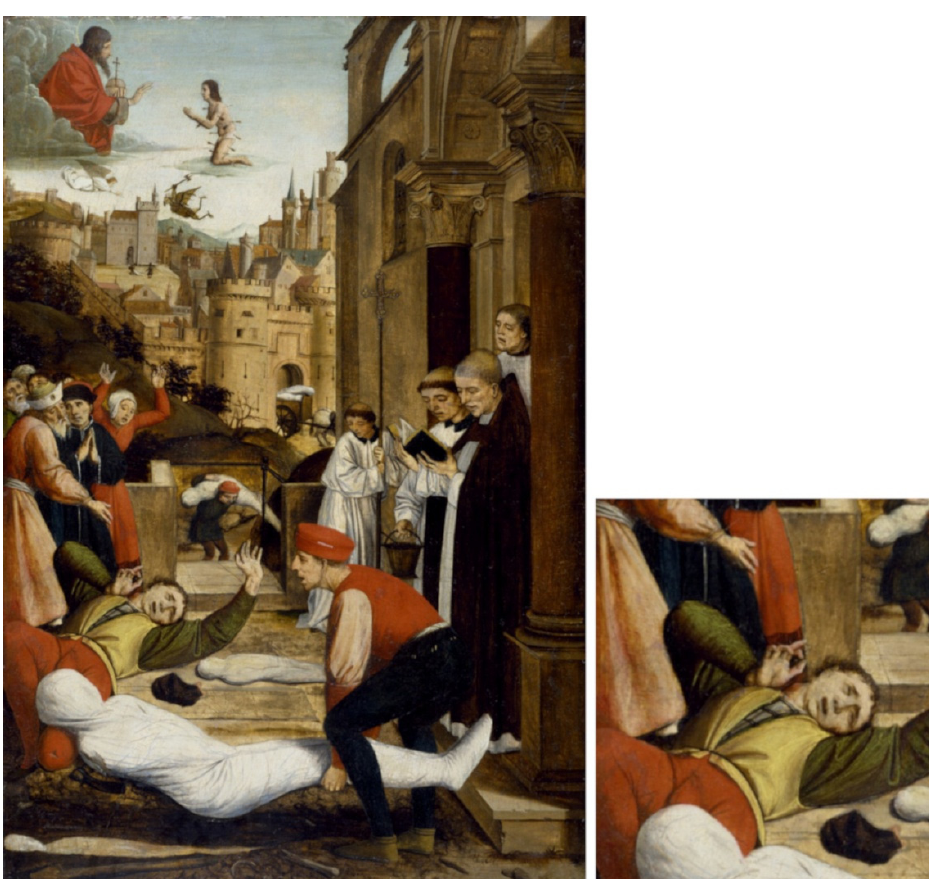
Figure 1. Adapted from “Saint Sebastian interceding for the Plague Stricken in Pavia”, created by Josse Lieferinxe (French painter, active 1493–1505). Source: The Walters Art Museum, Baltimore [51]. The Plague started in Asia, crossed Persia and the Middle East, and then entered Europe, which, according to the data compiled by Benedictow [10], would have killed 60% of the European population, which, when considering that there were between 50 to 80 million inhabitants of Europe at that time, represents a brutal catastrophe. This terrible pandemic reduced the world population from an estimated total of 450 million to around 350 million. For example, England’s population decreased by almost 70%, falling from about six million inhabitants before the Plague to only about 2.5 million afterwards [52].